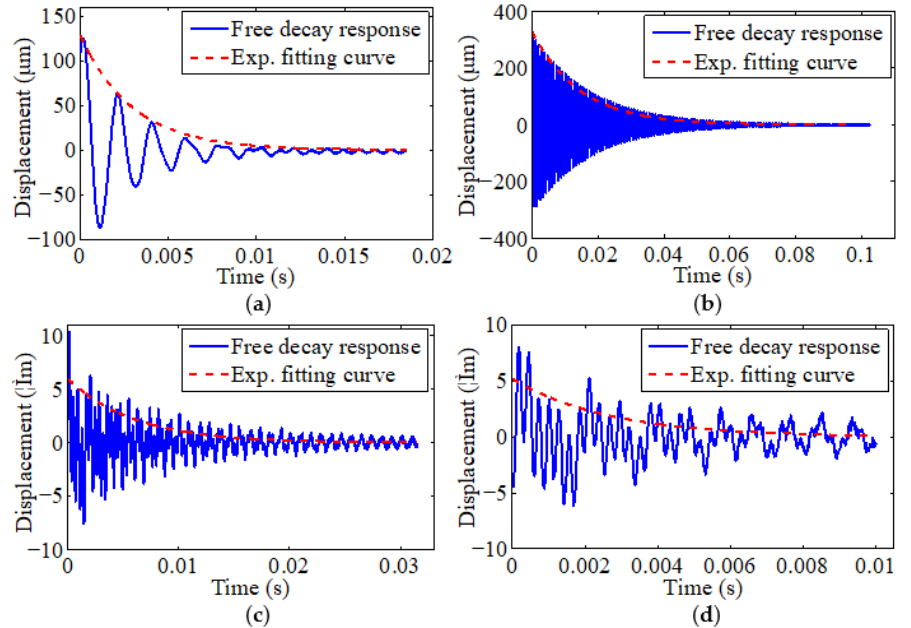
Figure 7. Identified exponential decay curves vs. tested resonance free decay responses of torque motor with MF . ( a ) First mode; ( b ) second mode; ( c ) third mode; ( d ) fourth mode.